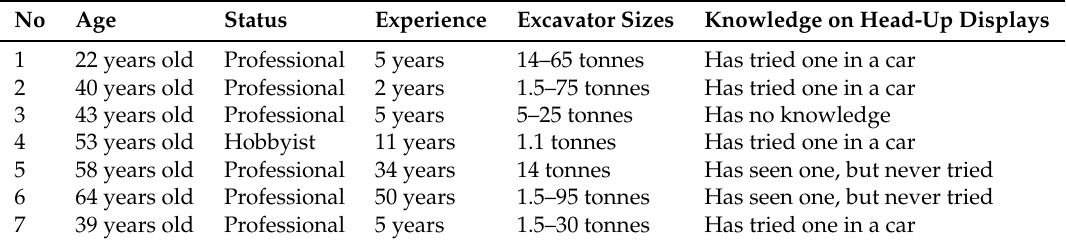
Table 1. The profiles of excavator operators that we interviewed.